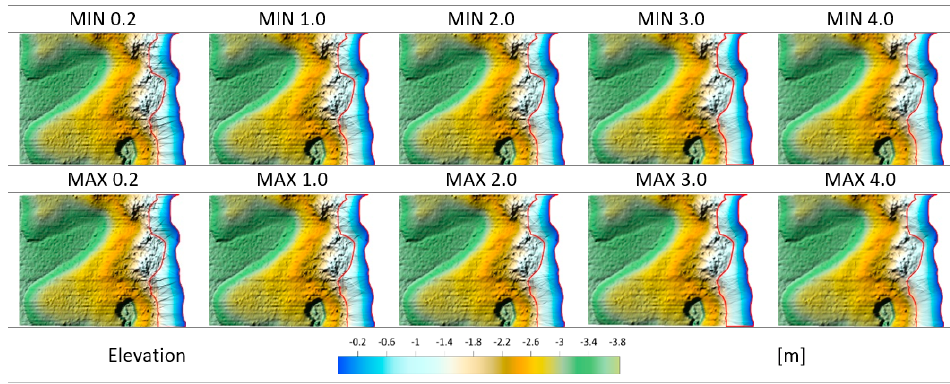
Figure 16. Comparison of DBMs under the kriging method.